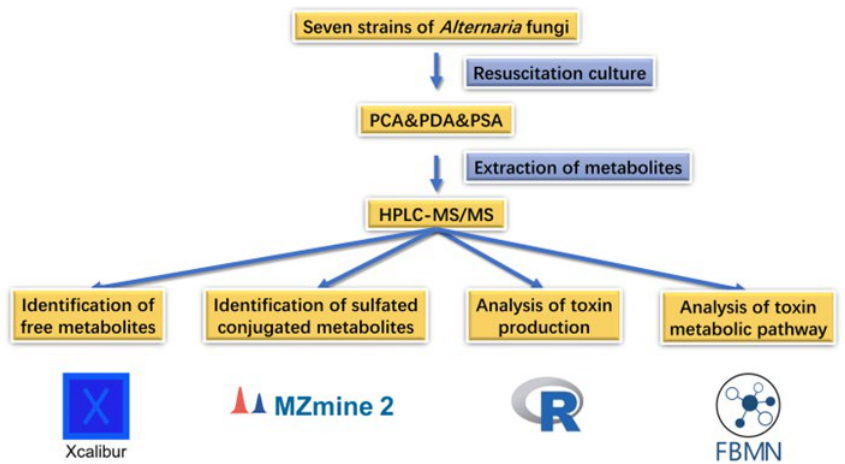
Figure 1. Research Figure 1. Research method.